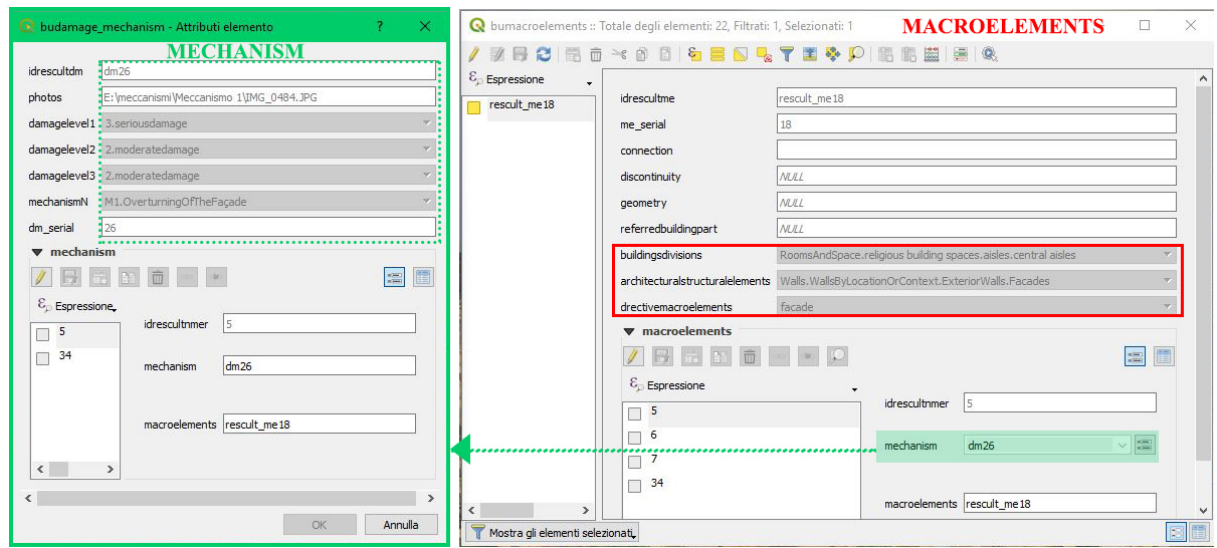
Figure 9. Façade macro-element attributes table information and its relationship with mechanisms attributes.